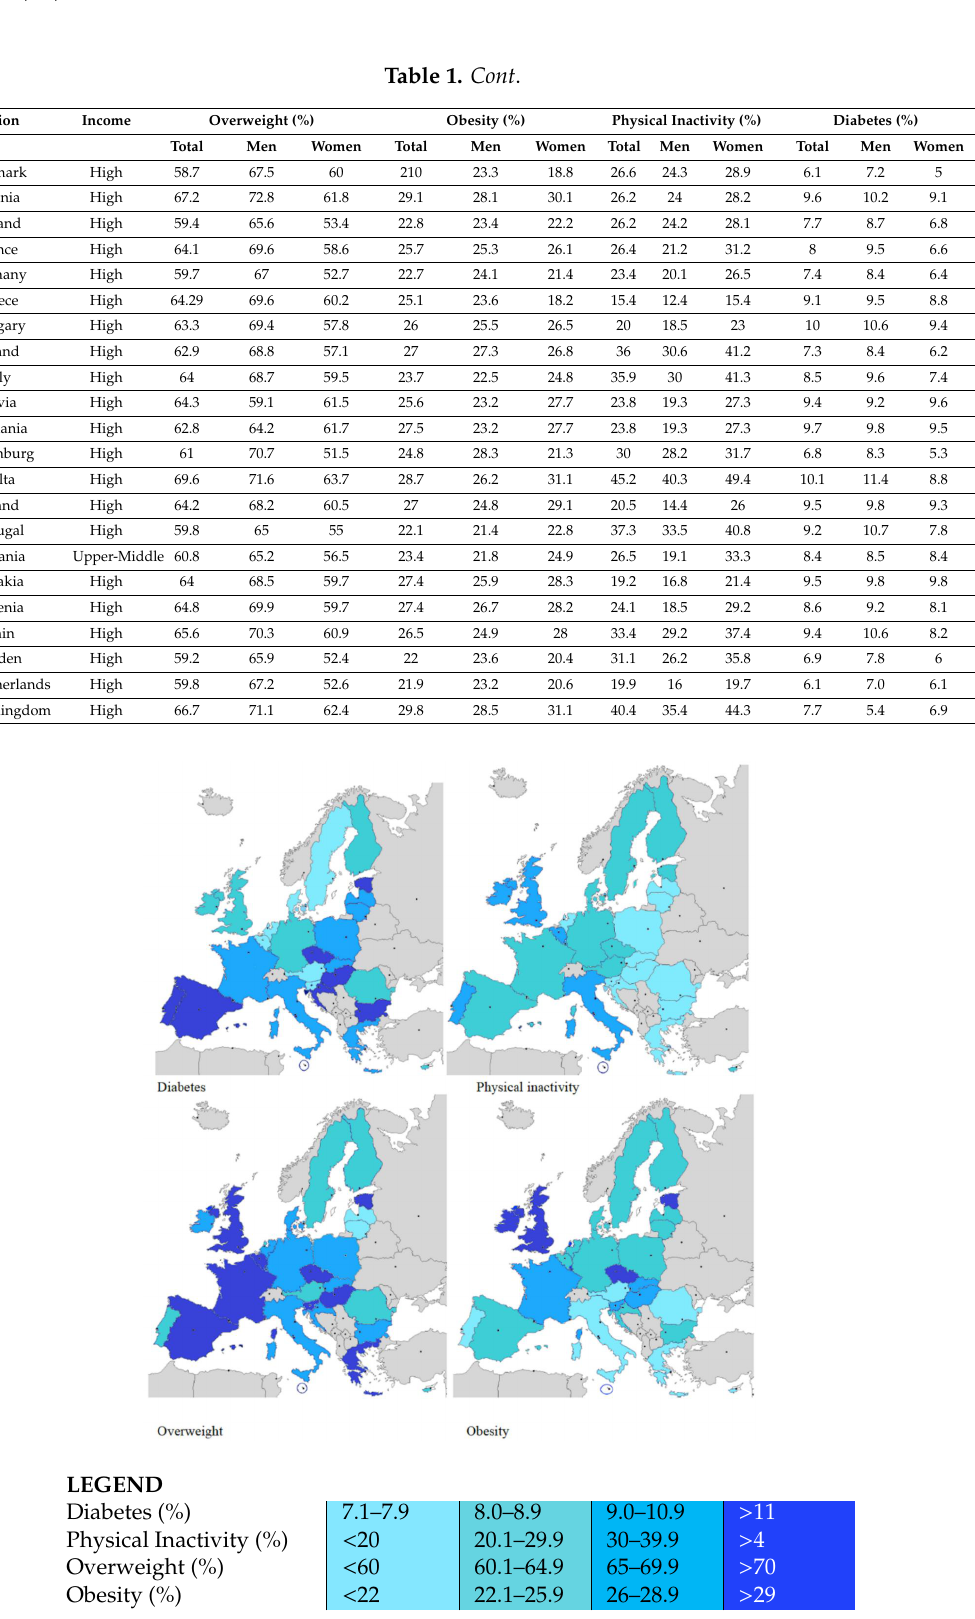
Figure 1. Type 2 diabetes and risk factors in